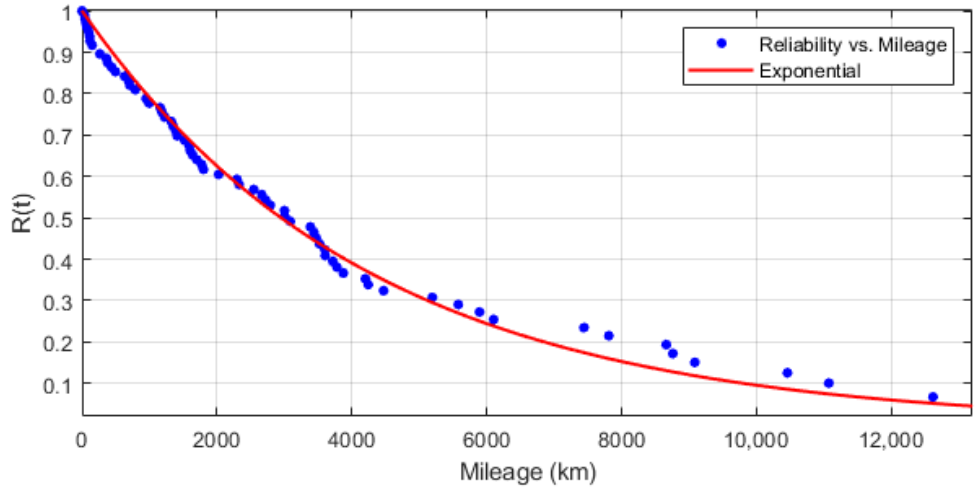
Figure 5. Graph presenting exponential model fitting to estimated values of reliability function.